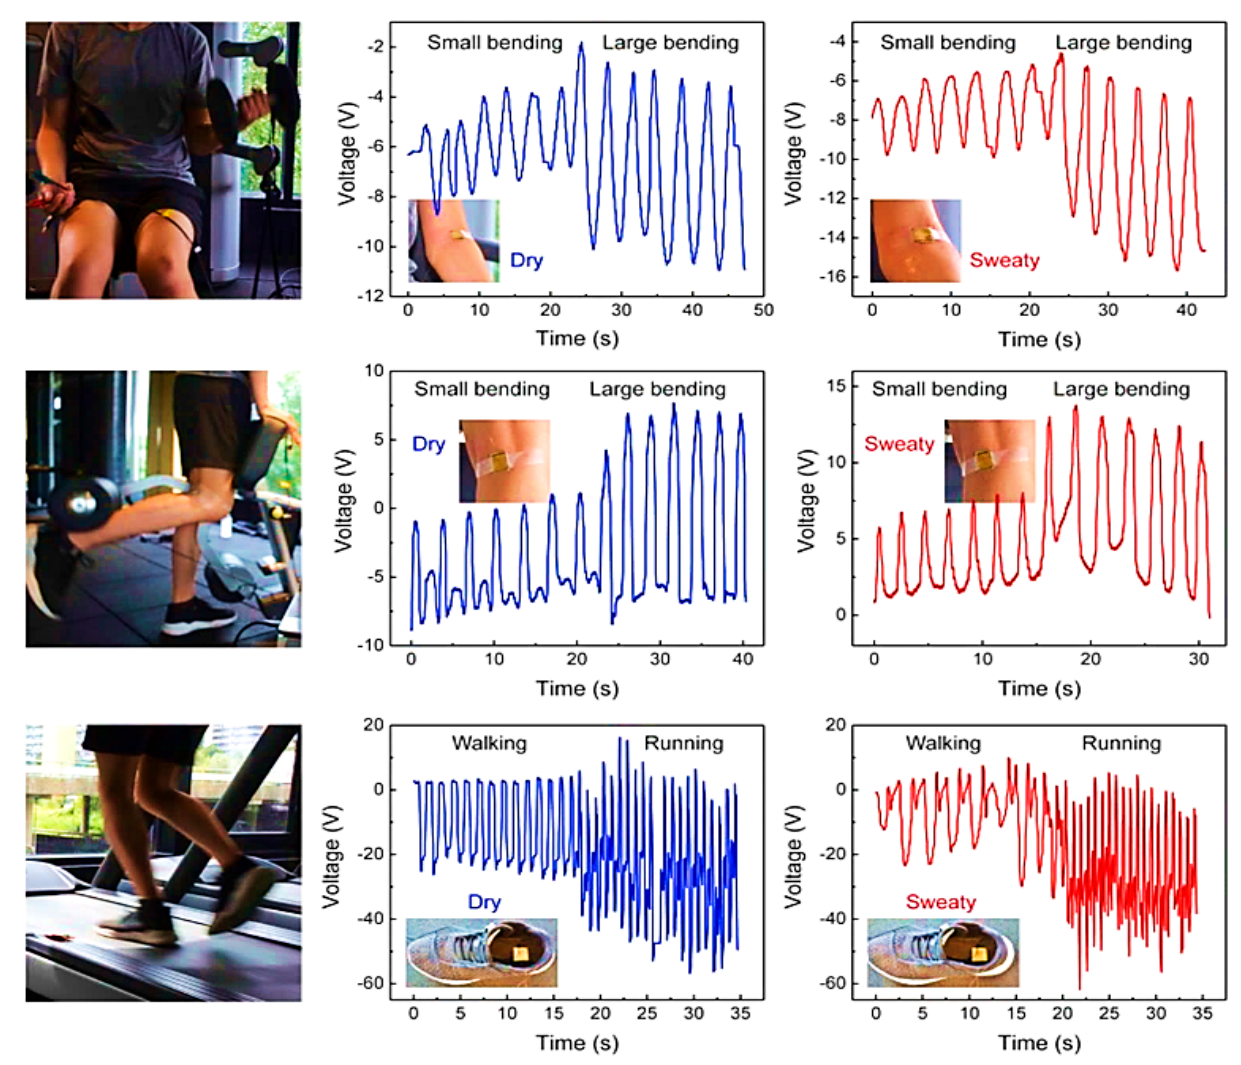
Figure 14. BSRW–TENG sensor applied to the elbow for monitoring biceps curl, leg curl, running, and walking—before and after sweating—with the corresponding plots of generated output voltages [41].